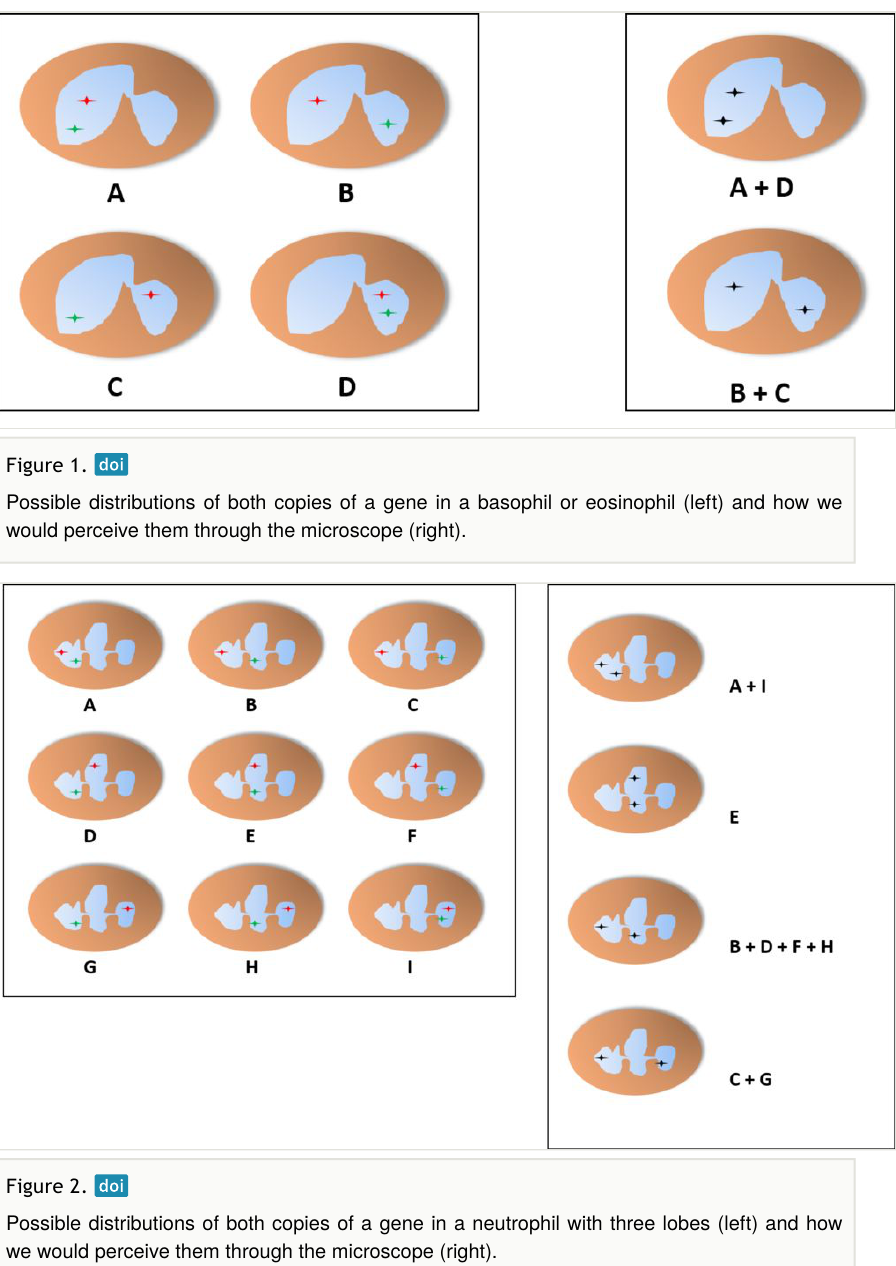
Figure 2. Possible distributions of both copies of a gene in a neutrophil with three lobes (left) and how we would perceive them through the microscope